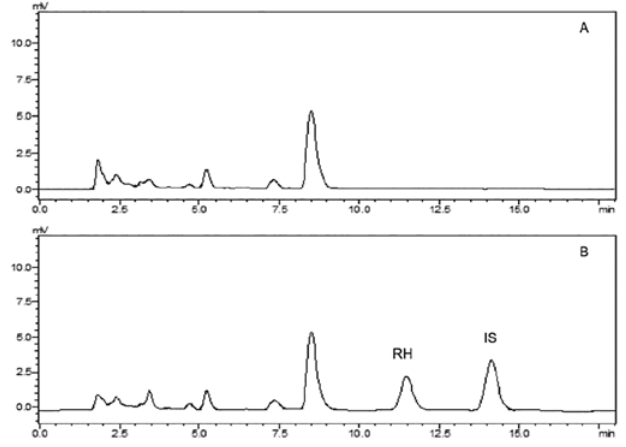
FIGURE 1 - Chromatogram obtained for (A) blank plasma, (B) blank plasma with raloxifene hydrochloride at 500 ng.mL -1 (RH), and internal standard 10 µg.mL -1 – (IS).